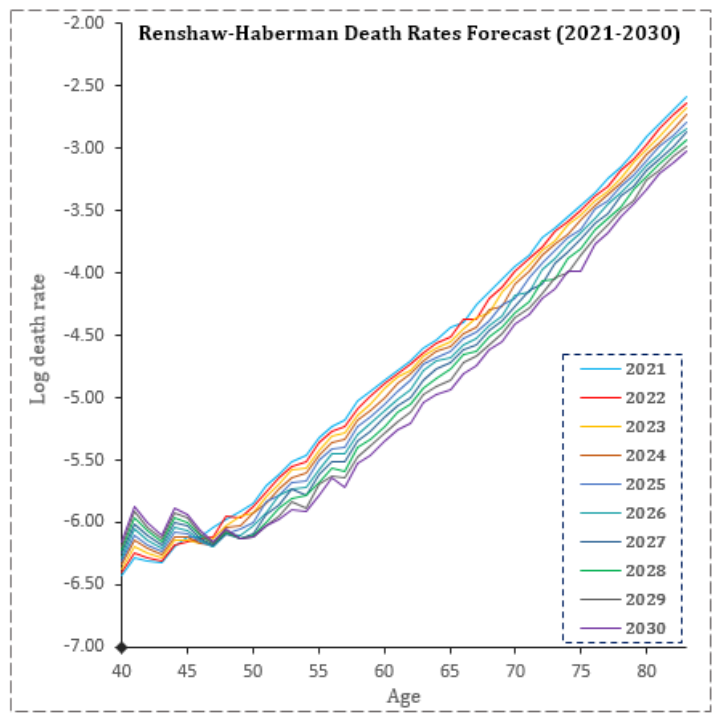
Figure A2. Renshaw–Haberman Rate Forecast for Period 2021–2030.